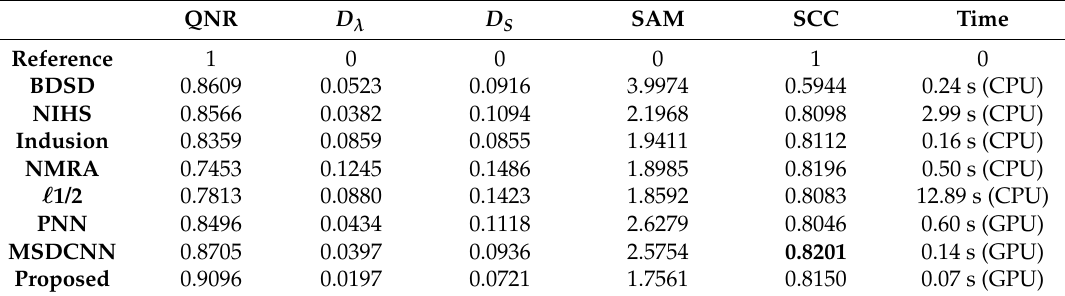
Table 2. Performance indictors at original scale on WorldView-2 dataset.